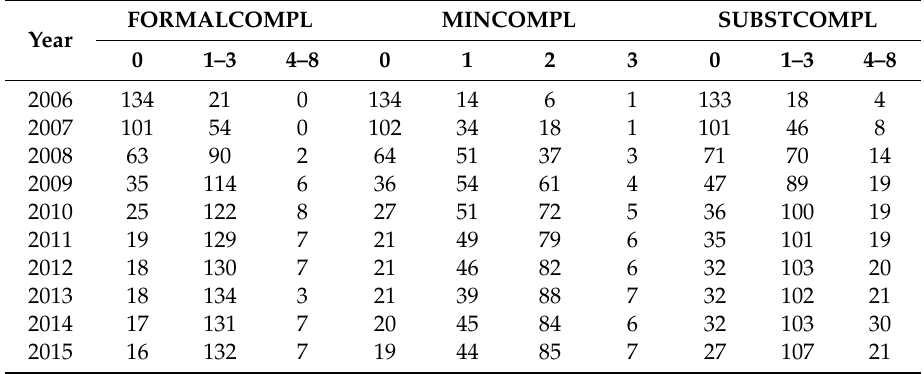
Table 8. Distribution of compliance variables (formal, minimum, and